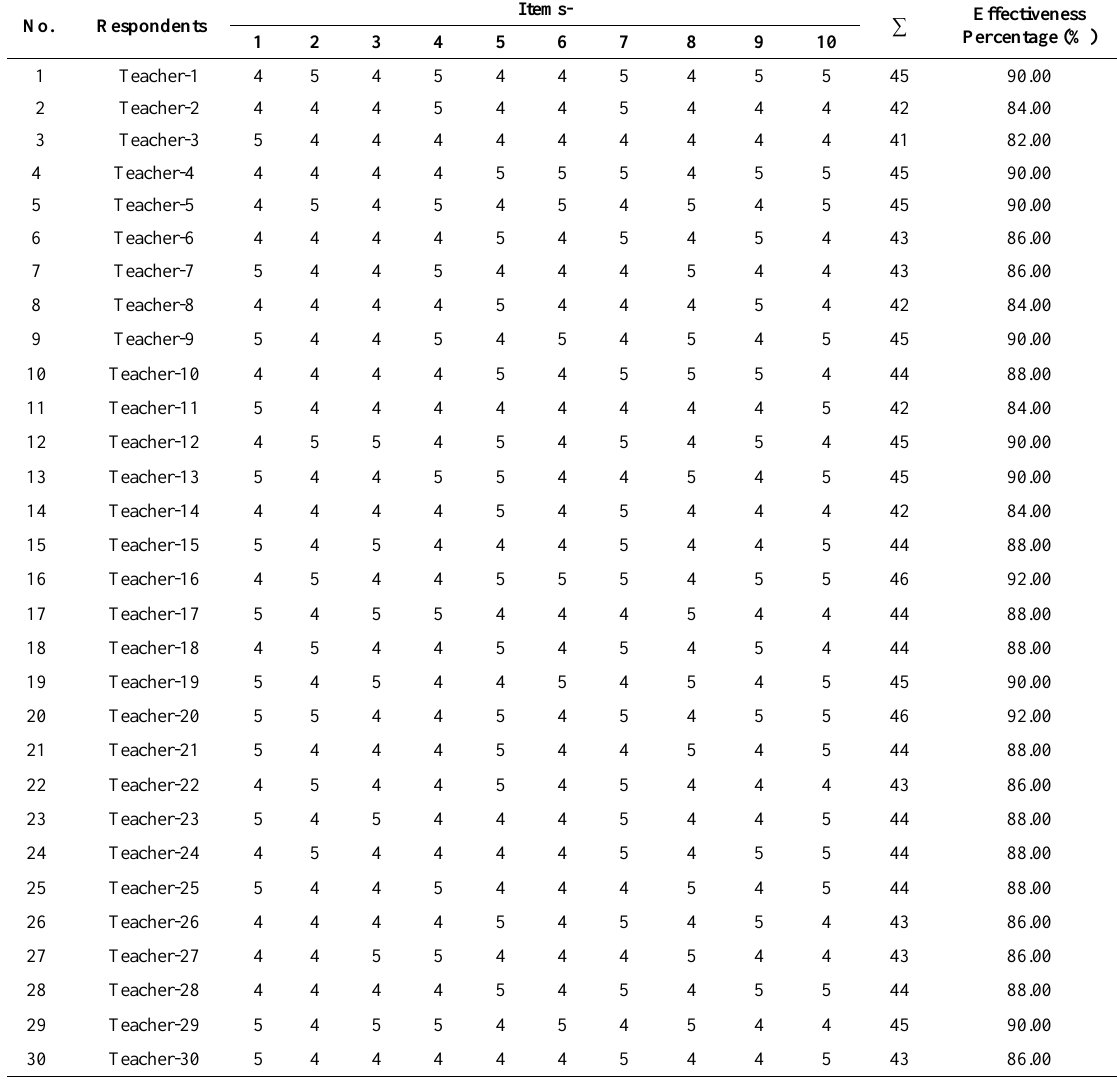
Table 7. Trial results of TOPSIS calculation to determine the dominant aspect that priority for improvement.